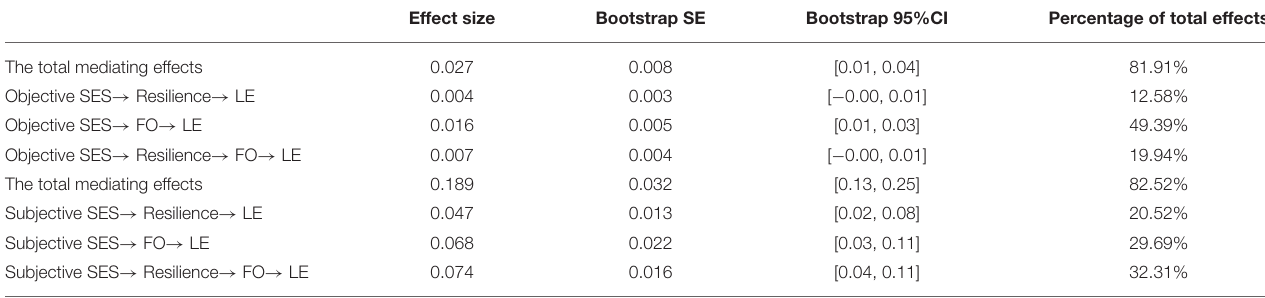
TABLE 3 | Bootstrap analysis of multiple mediation